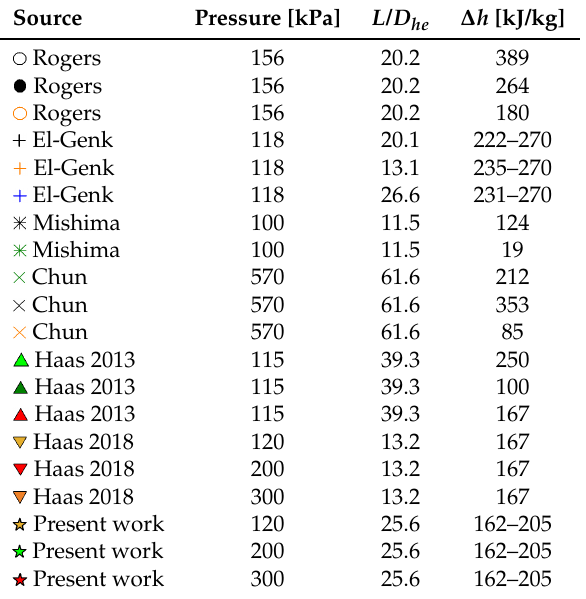
Table 7. Experimental parameters of CHF literature data depicted in Figure 11. Source Pressure [kPa] L / D he ∆ h